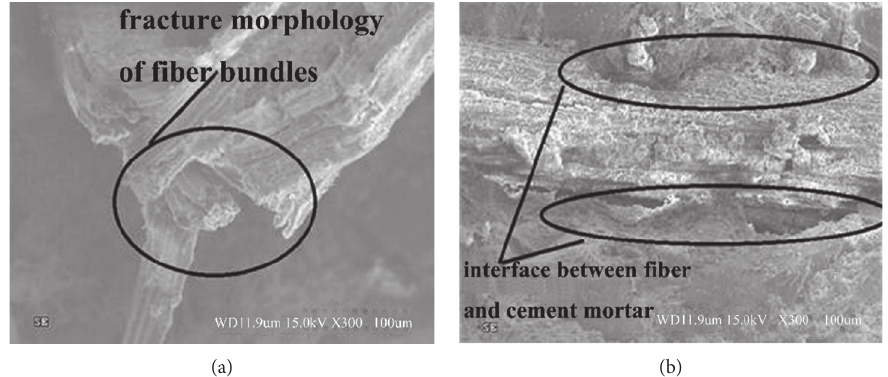
Figure 10: Interface area of the sisal fiber and the cement mortar.